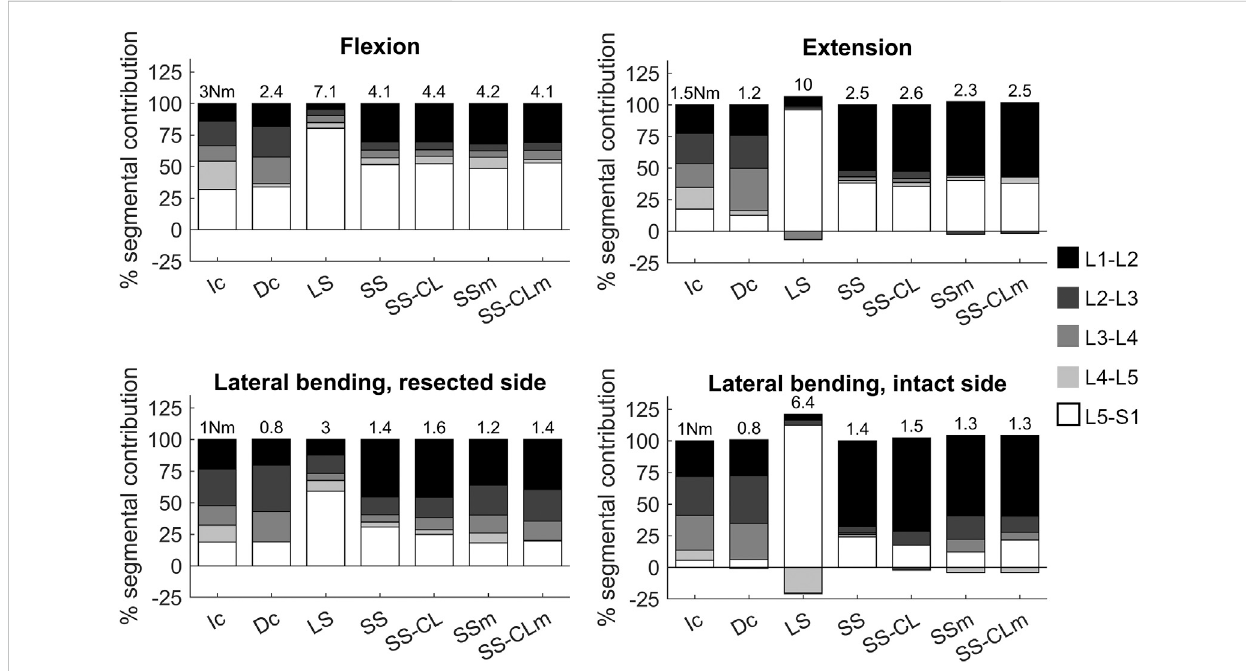
FIGURE 6 Motioncontribution ofeachvertebrallevelapplyingthehybridprotocol(Panjabi,2007)toeachcon fi guration.Eachcontributioniscalculatedasthe percentageofthetotalL1-S1motionobtainedbyIcat3 Nmin fl exion,1.5 Nminextension,1 Nminlateralbending.Labeloneachhistogramindicatesthe applied moment necessary to reach the appropriate ROM in